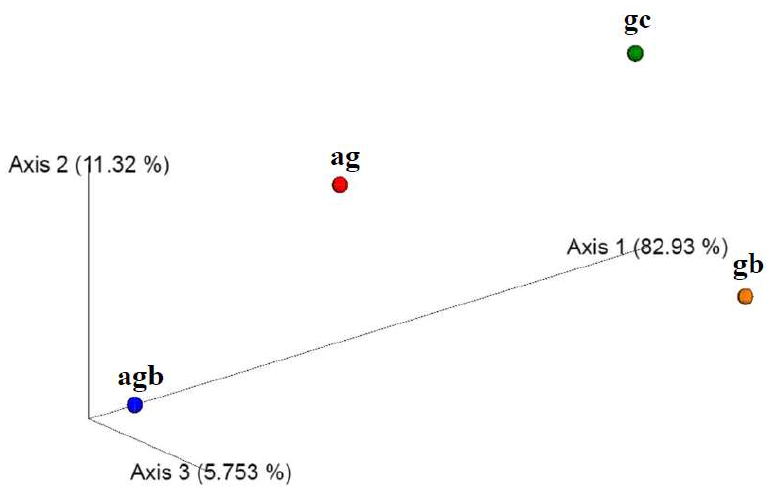
Figure 6. Bray-Curtis distances, calculated as a quantitative measure of community dissimilarity for the four samples. Labels represent: (ag) Algae + Granules, (gc) Granules Control, (agb) Algae + Bacteria + Granules, (gb) Granules + Bacteria.